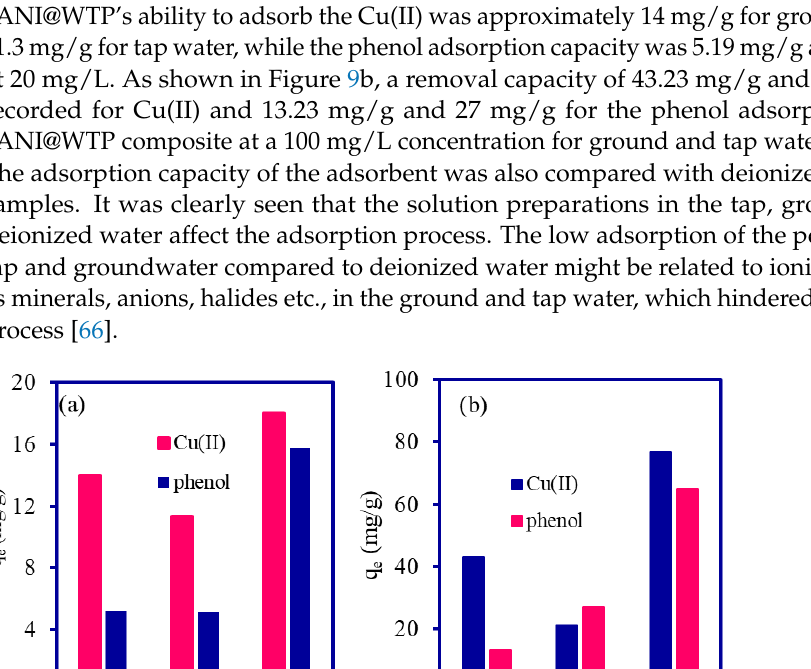
Table 3. Comparison of maximum adsorption capacity of Cu(II) and phenol with other materials.